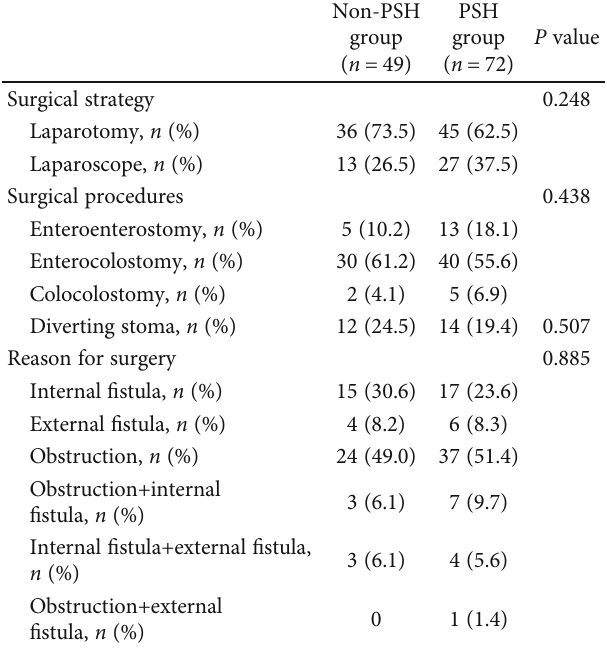
Table 2: Surgical therapies and rationale in treatment cohorts.